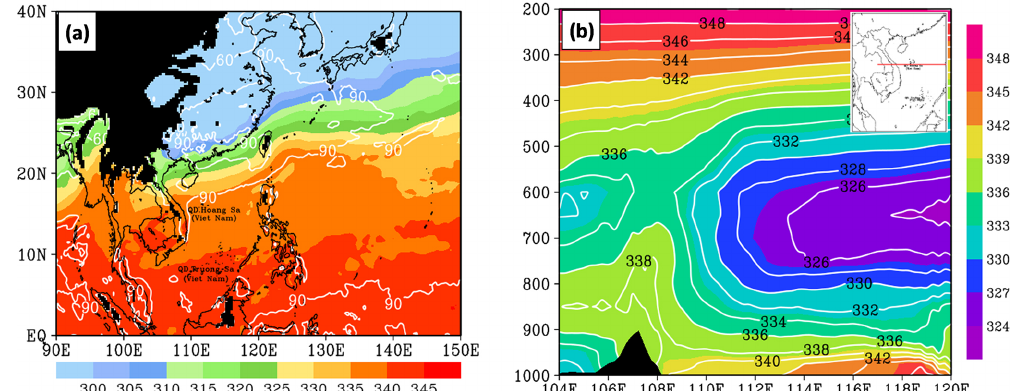
Figure 4. (a) The ERA5 averaged equivalent potential temperature (K, color) and relative humidity (%, white contours, every 30%) at 925hPa. The black areas are where the 925hPa level is below the ground. (b) The east–west vertical cross-section along 16 ◦ N (see insert) of averaged equivalent potential temperature ( θ e , K, color, every 5K) from 00:00UTC on 8 December to 18:00UTC on 11 December 2018. The topography is dark